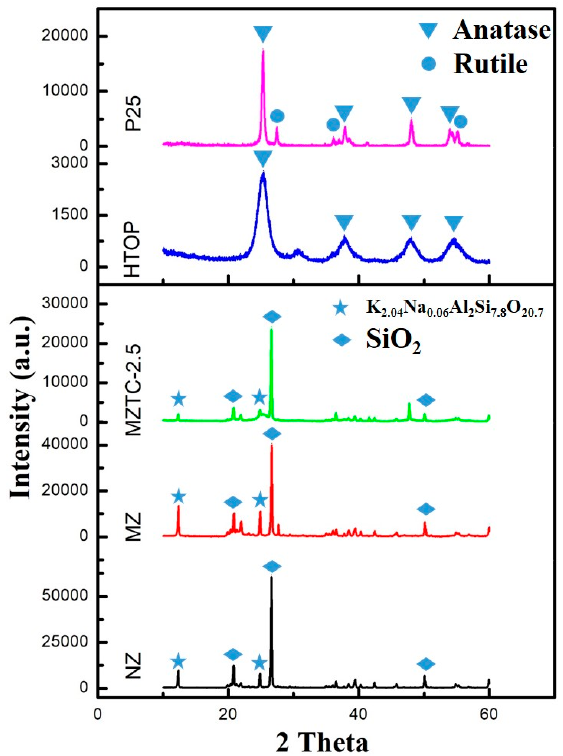
Figure 1. X-ray diffraction patterns. (a.u. = arbitrary units) 92 Figure 1. X-ray di ff raction patterns. (a.u. = arbitrary